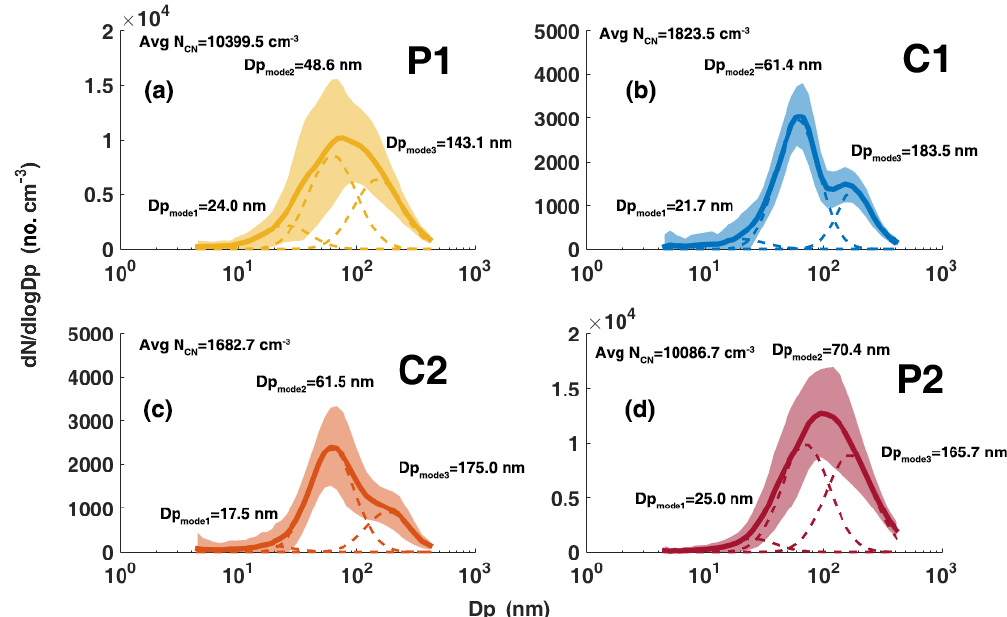
Figure 9. The average and SD (shaded area) PNSD, along with trimodal lognormal fitted modes (dashed colored lines). The average N CN during each period and the median size of each lognormal fit are shown. Table 2. Summary of average N CCN , D 50 , and N CCN /N CN,tot